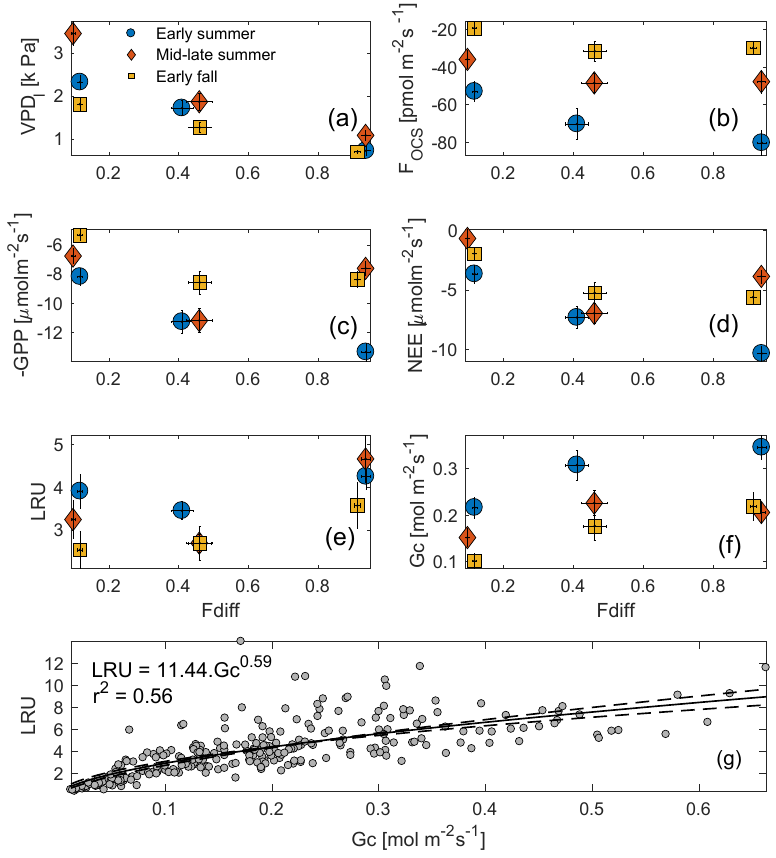
Figure 6. Midday VPD l , F OCS , NEE, and GPP plotted against the fraction of diffuse downwelling shortwave radiation (a–d) for early summer, mid–late summer, and early fall of 2015 (these periods are defined in Sect. 3.4). High values on the x axis indicate completely overcast or cloudy conditions, whereas as low values indicated clear skies. LRU increases with increasing fdiff during each period, but the increase is most pronounced in the early summer (e) . Gc increases from clear to partly cloudy conditions across the three periods and plateaus during overcast sky conditions (f) . Vertical bars indicate 1SE. Across the three periods, LRU increased with Gc and leveled off at Gc values greater than ∼ 0.5molm − 2 s − 1 (g)